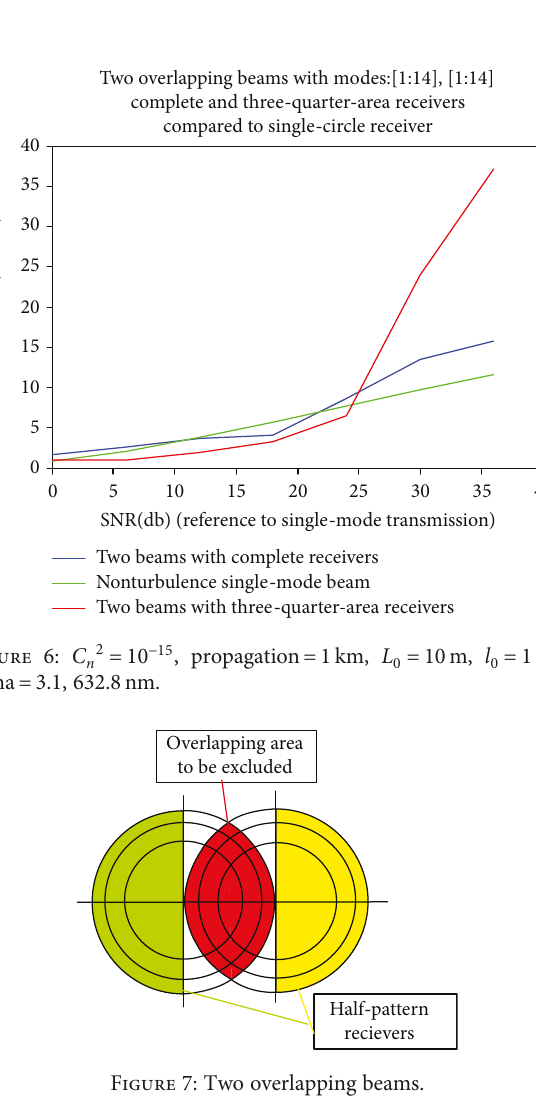
Figure 7: Two overlapping beams.